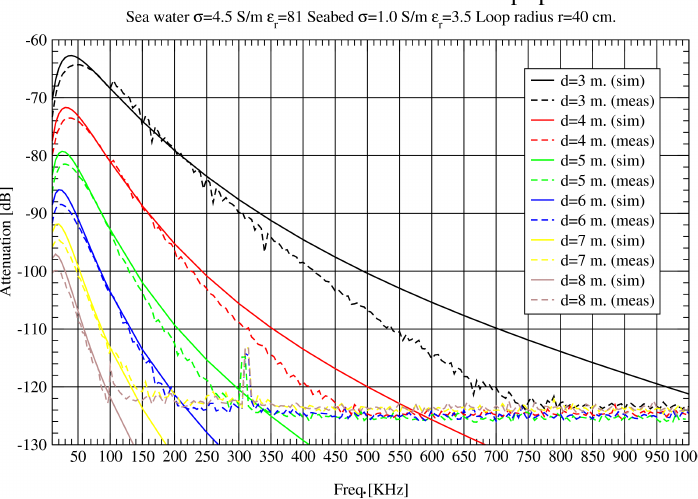
Figure 10. Path loss (dB) comparison up to 8 m (10 KHz–1